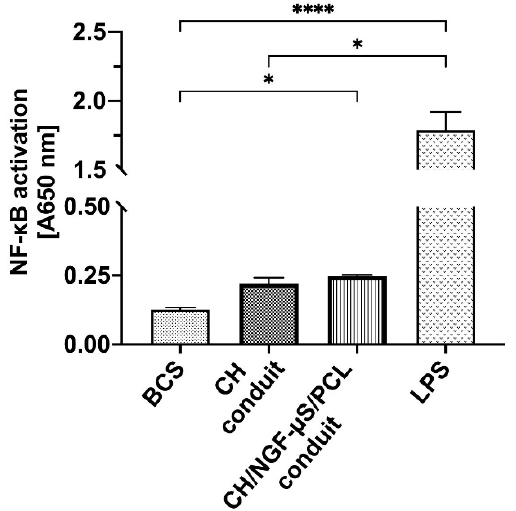
Figure 10. The NF- κ B induction in THP1-Blue™ human monocytes exposed to CH or CH/NGF- µS/PCL conduits, BCS reference biomaterial (negative control), or E. coli lipopolysaccharide (LPS) at 0.25 IU (positive control). Data are shown as a mean from four repeats with error bars that indicate standard deviation. Values with statistically significant differences are labeled by brackets and asterisks as follows: * p < 0.05, **** p < 0.0001. Data were compared using a regular one-way ANOVA followed by Tukey’s multiple comparisons.